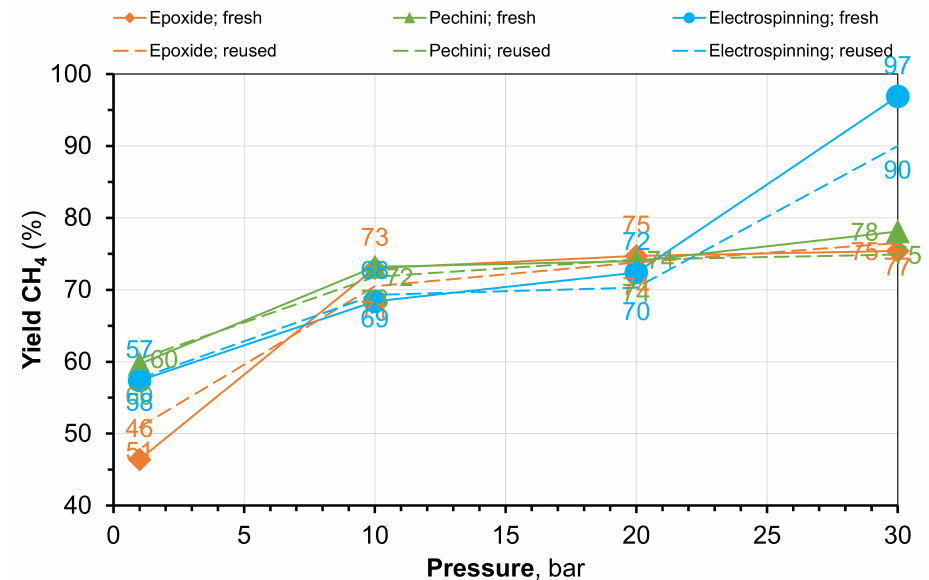
Figure 3. Methanation of CO 2 over reused nickel–cerium bimetallic oxides at 300 ◦ C without pre- treatment under hydrogen: effect of preparation method on yield to CH 4 .